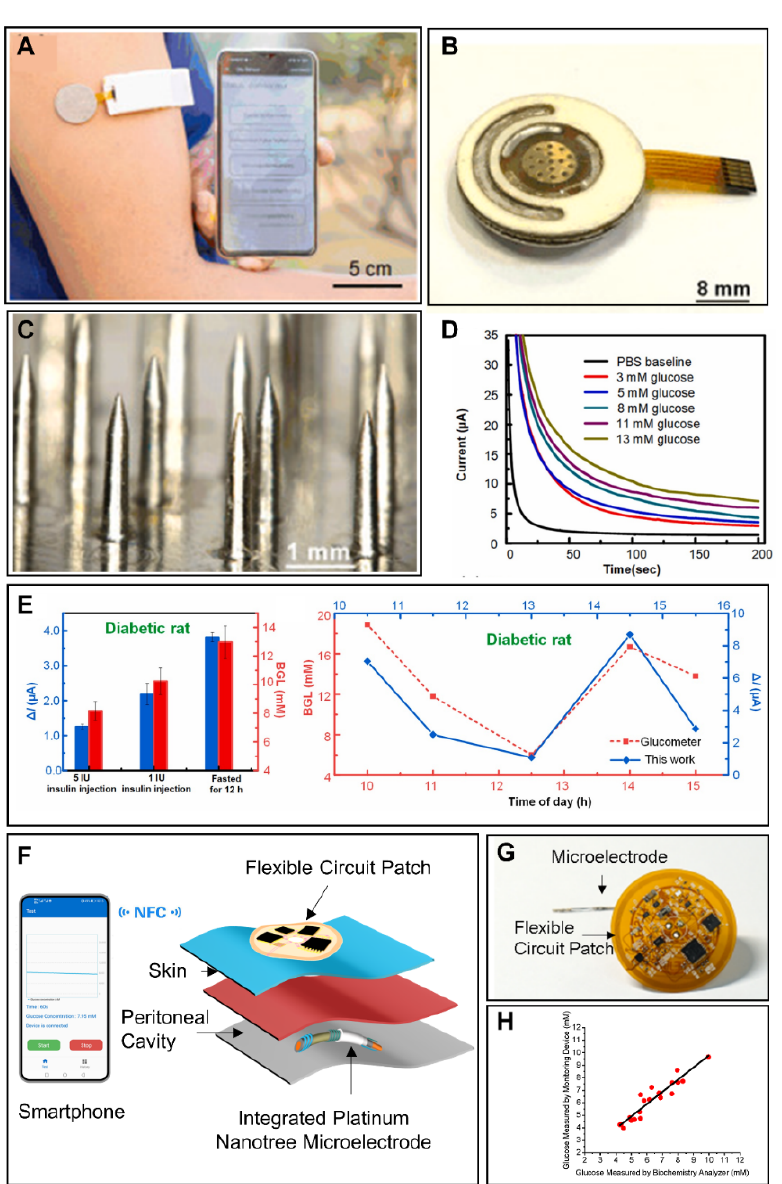
Figure 4. Smartphone-based implantable glucose monitoring. ( A ) Smartphone-based ISF glucose